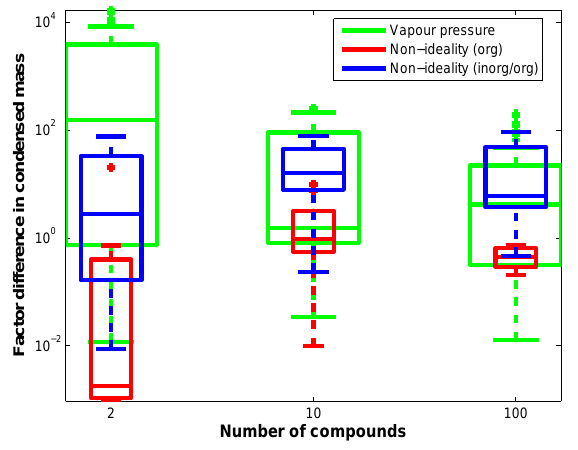
Fig. 12. An example illustration of the sensitivity of predicted to- tal condensed organic mass across all conditions to the differences in vapour pressure predictive technique in the partitioning model (green bars, n = 45), the inclusion of non-ideality for the aque- ous mixture of organics(red bars, n = 9) and the inclusion of non- ideality for a mixture including sodium chloride at a mass ratio of 1:1 with the base case condensed mass (blue bars, n = 9). The box- plots encompass all T- and